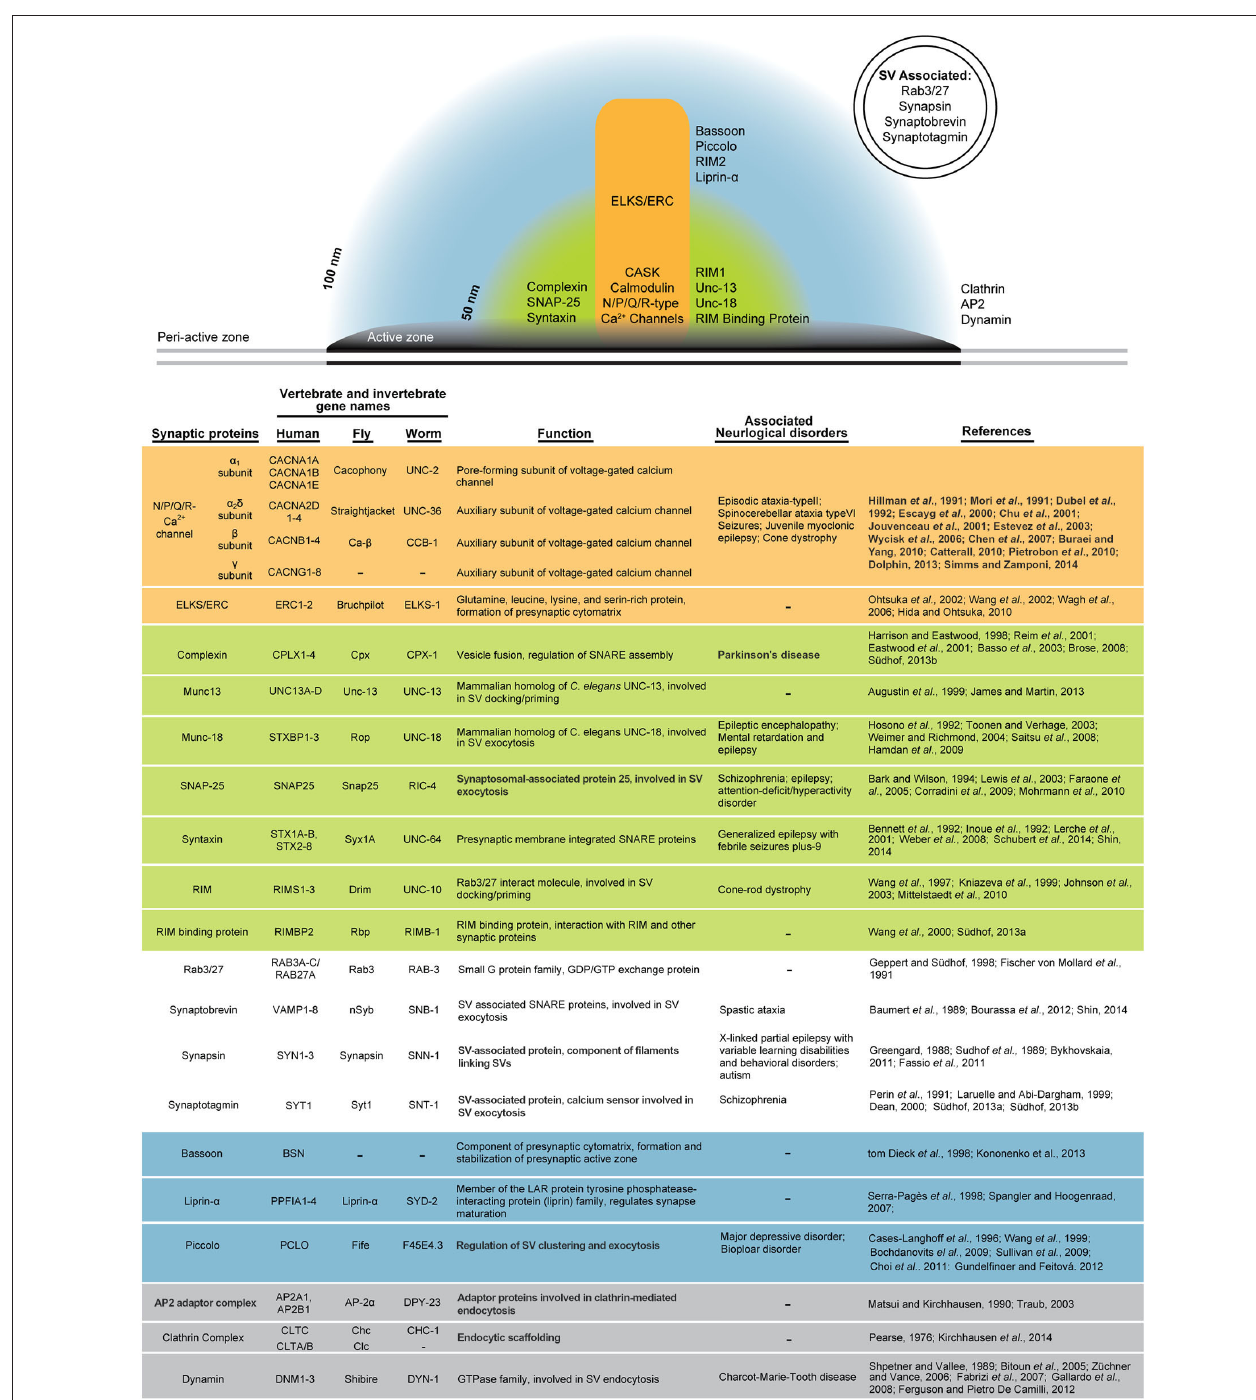
peri-active zone beyond the electron dense AZ membrane (gray), and SVs that may transiently occupy any of the other zones. Presynaptic proteins discussed in this review are grouped according to their predominant localization and described in detail. For each molecule, conservation in multiple species is indicated with the gene name from humans, flies, and worms. Links between presynaptic proteins and human neurological disorders are